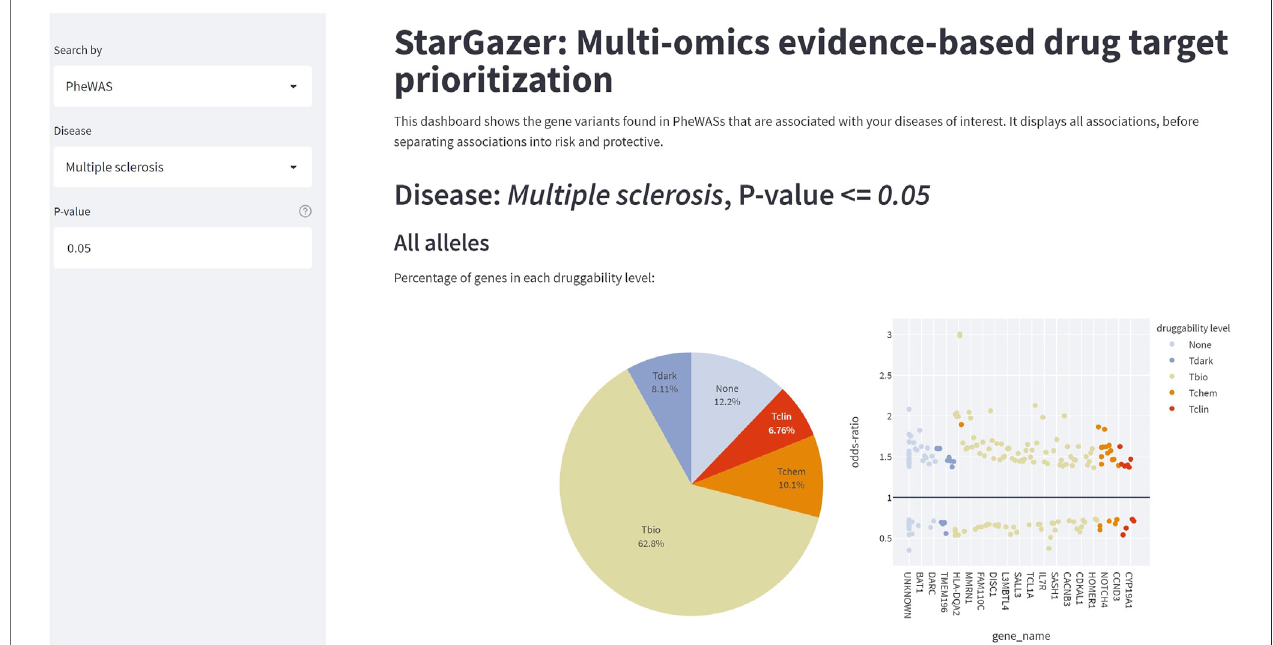
FIGURE 3 | The StarGazer interface after searching “ Multiple sclerosis ” in PheWAS mode. At p = 0.05, 7.37% of genes with associations with multiple sclerosis werecategorizedasTclin,i.e.,alreadytargetsofFDA-approveddrugs.Thedistributionofgenesineachdruggabilitylevelisshownbypiechartandscatterplot,thelatter of which also showing the odds ratios of each allele of each gene. Some gene names are not shown. This data is re-analyzed to show only risk alleles, or only protective alleles. Tabulated data can be visualized and downloaded. The StarGazer modes, GWAS and GWAS-PheWAS Union, are similar in appearance.